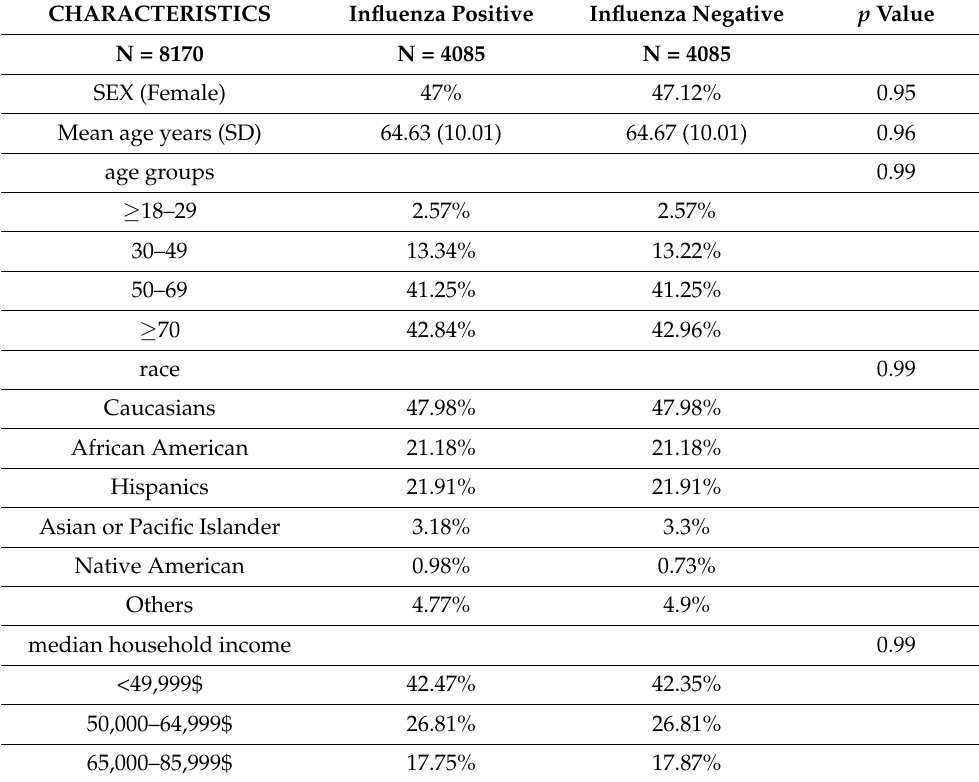
Table 4. Influenza and COVID-19 propensity 1:1 matched patient-level characteristics. SD = Stan- dard